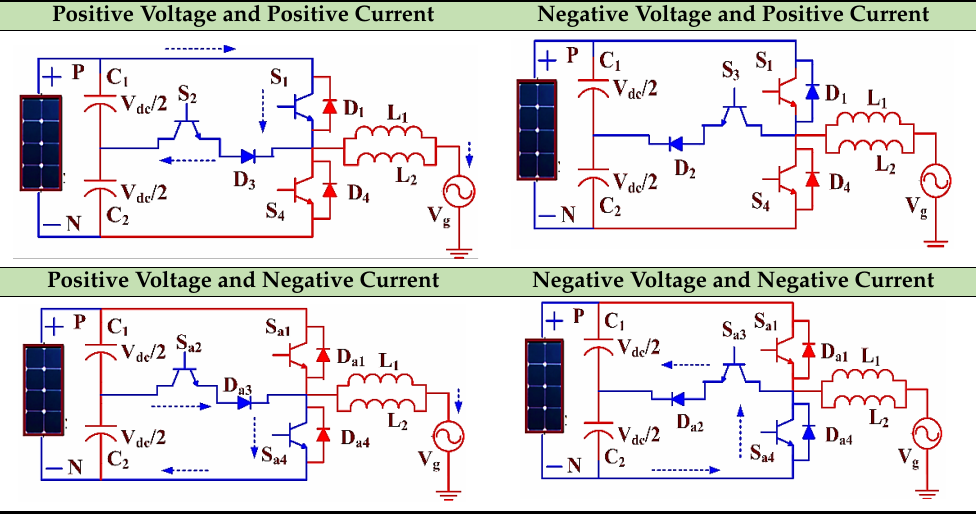
Table 2. Commutation interval, voltage, and current path for four operating